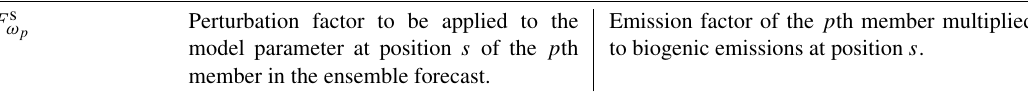
sions Biogenic emission rate from model setup j